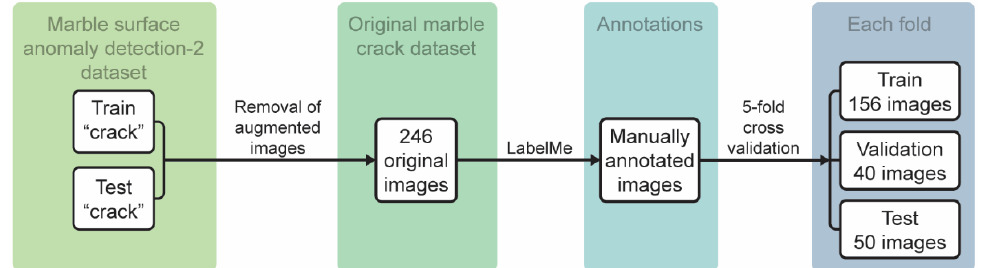
Figure 5. Formulation of the proposed marble crack dataset.